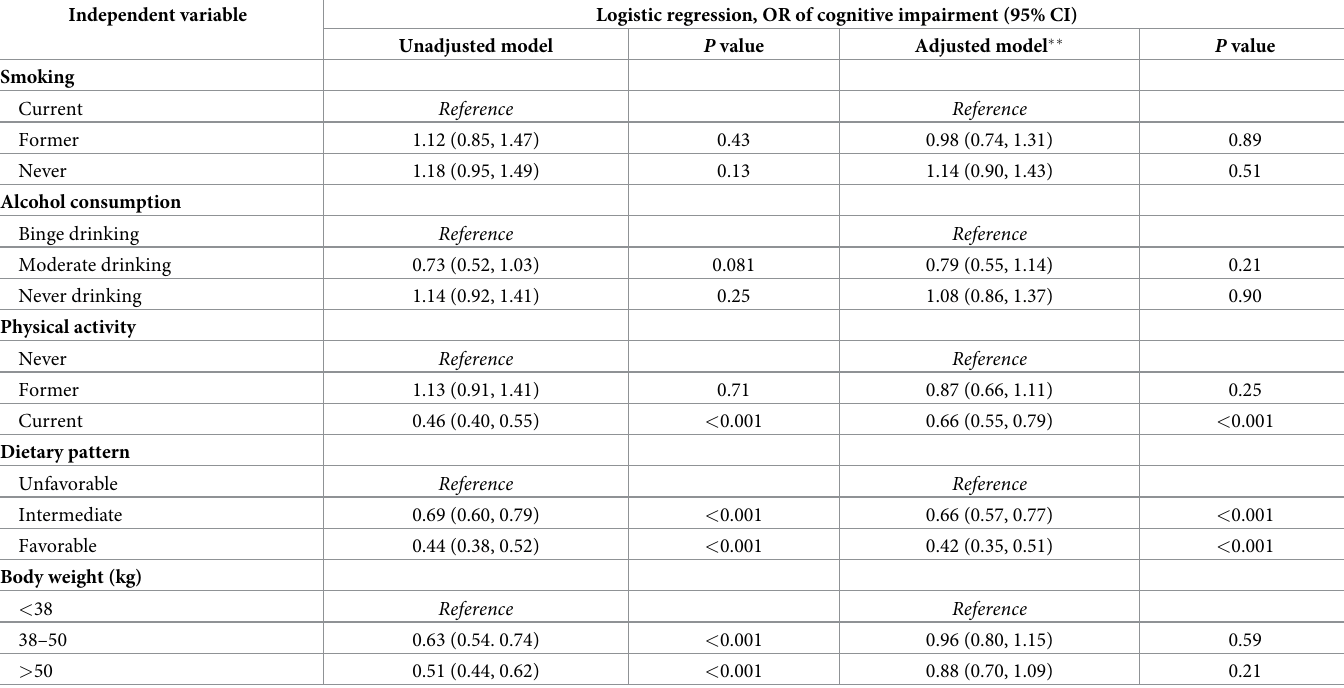
Table 2 AU : Pleasenotethatthefootnotedesignator � � isnotcitedinbodyofTable 2 : Pleasecheckandprovidethemissingdesignator : . Association between single lifestyle factor and cognitive impairment. � Independent